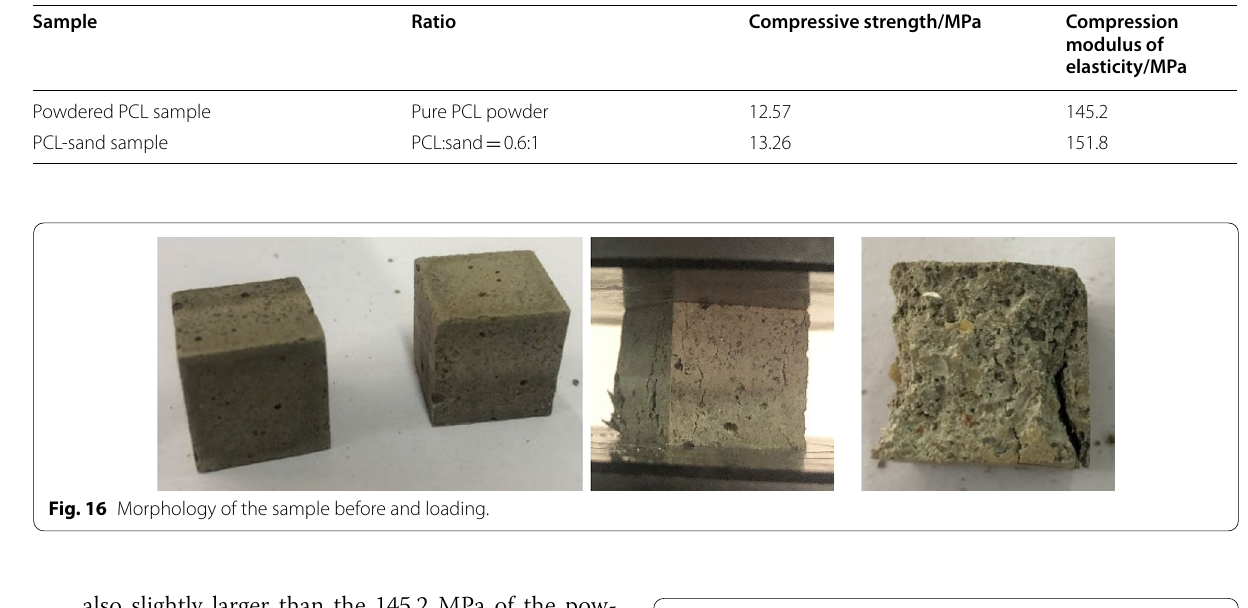
Table 6 Mechanical parameters of PCL‑sand sample and the powdered PCL sample.